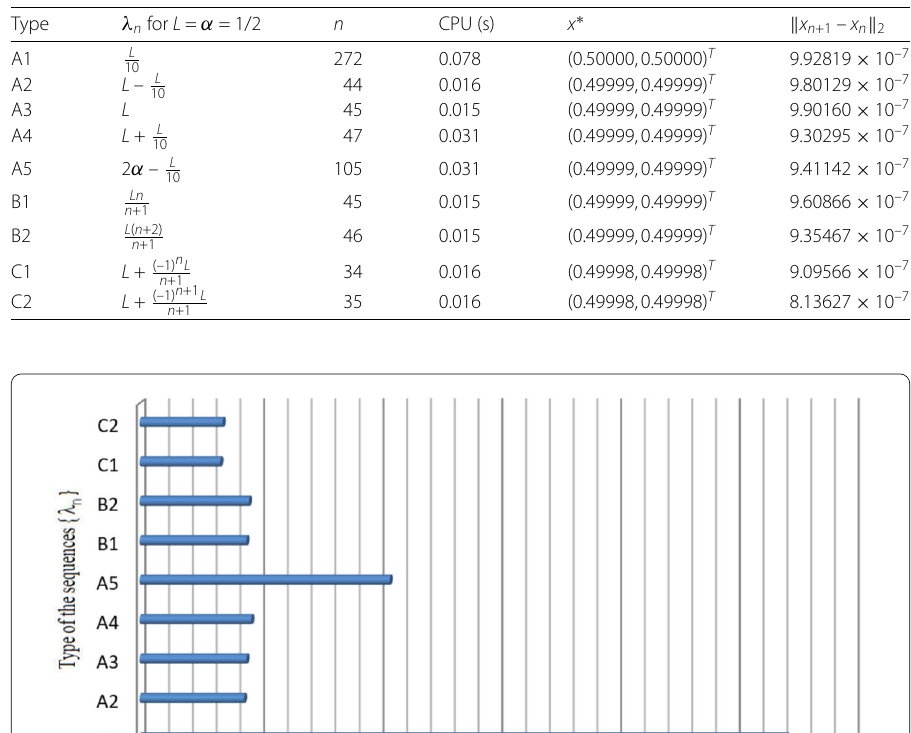
Table 1 Numerical results of Example 4.3 for the initial points x 0 = (–1,0) T and x 1 = (0,1) T using the algorithm in Theorem 4.1